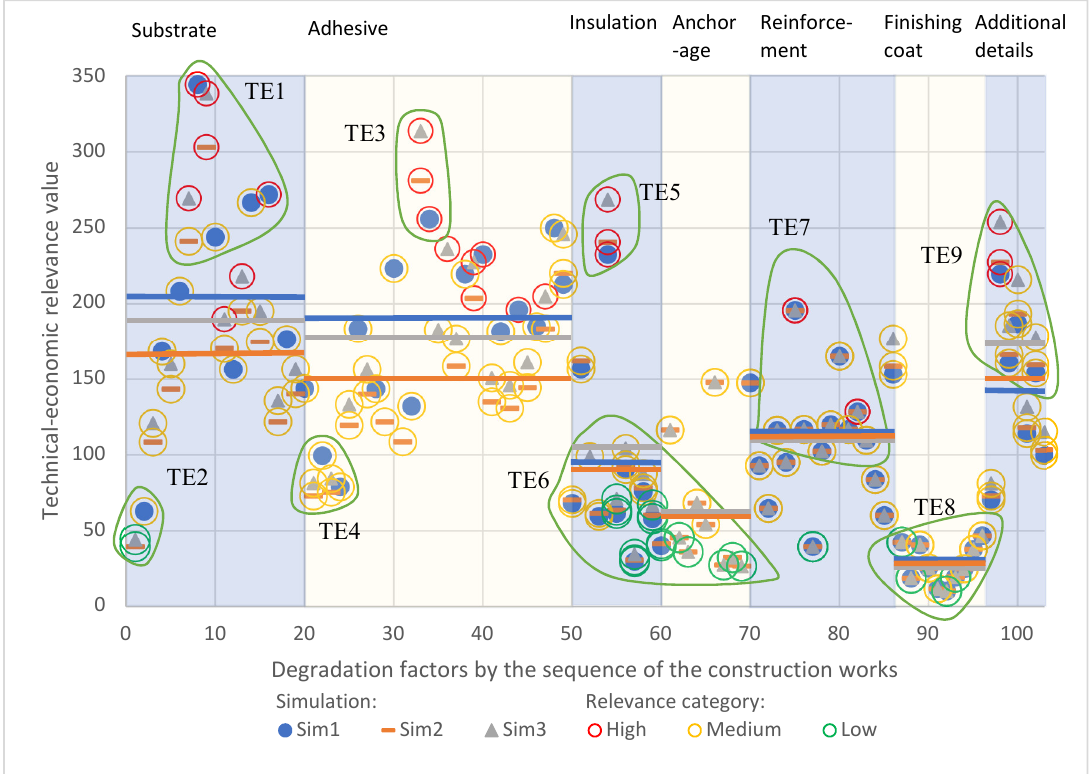
Figure 10. Technical–economic relevance (TER) values and risk categories of the degradation factors by the sequence of construction works.